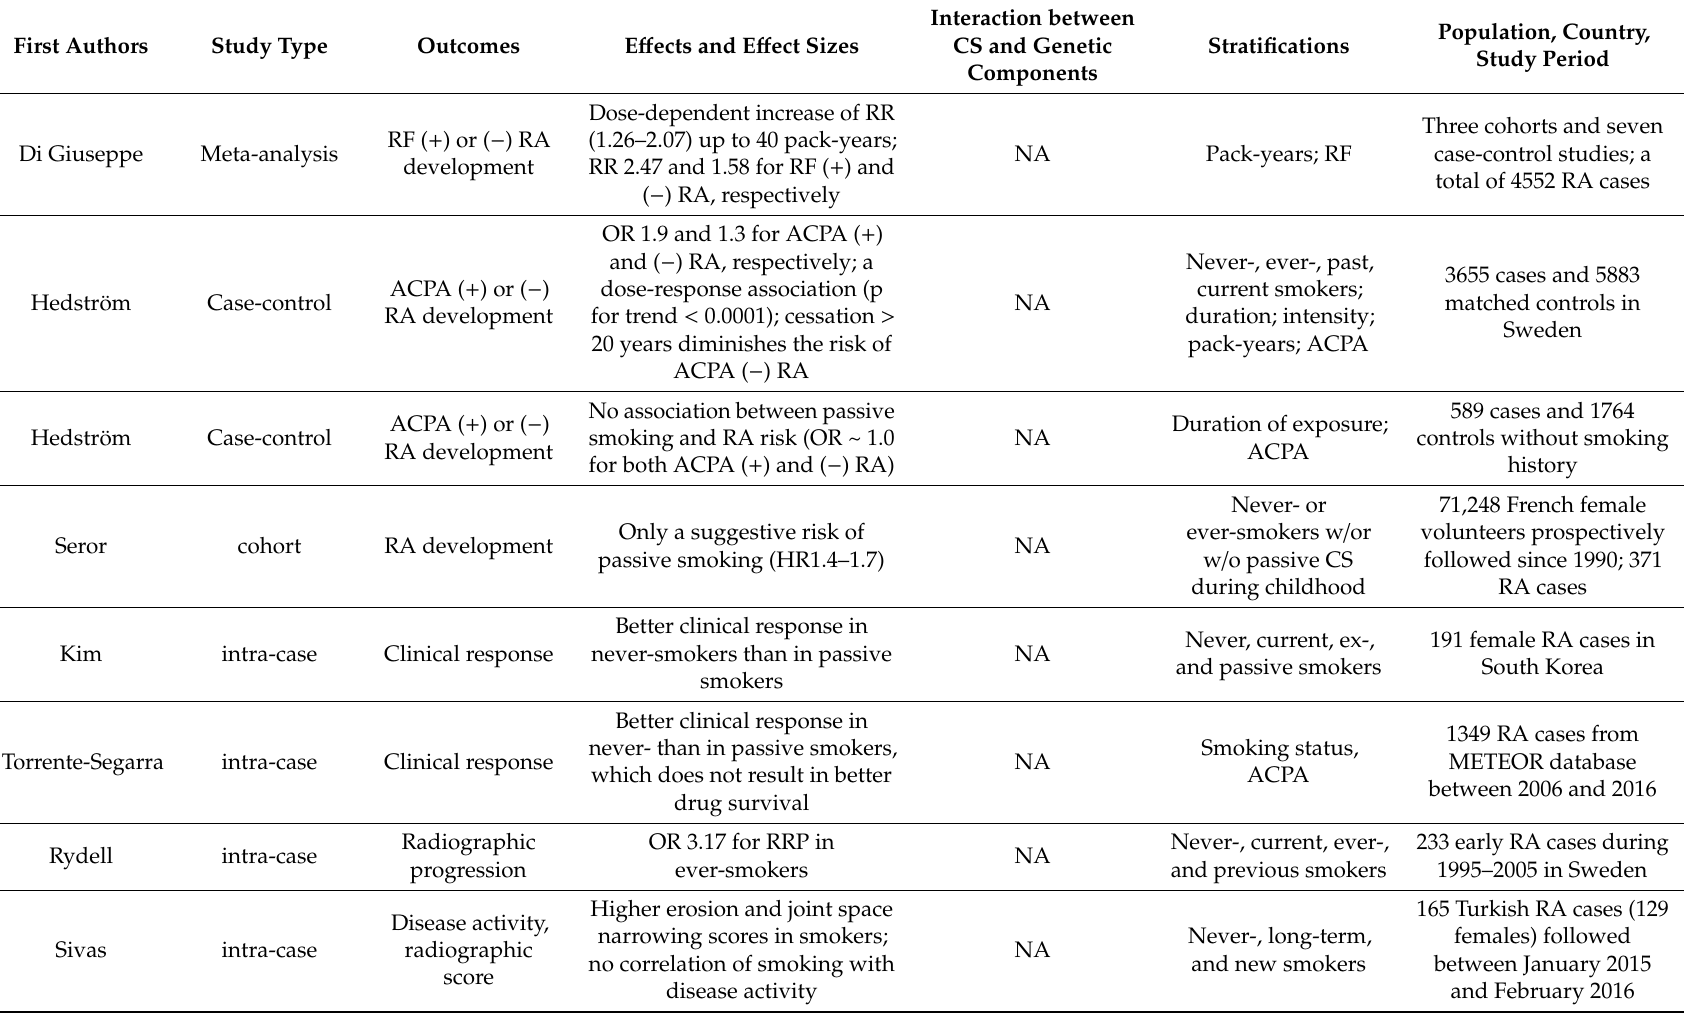
Table 1. The risks of cigarette smoking for rheumatoid arthritis (RA) development, RA-related pathologies, and